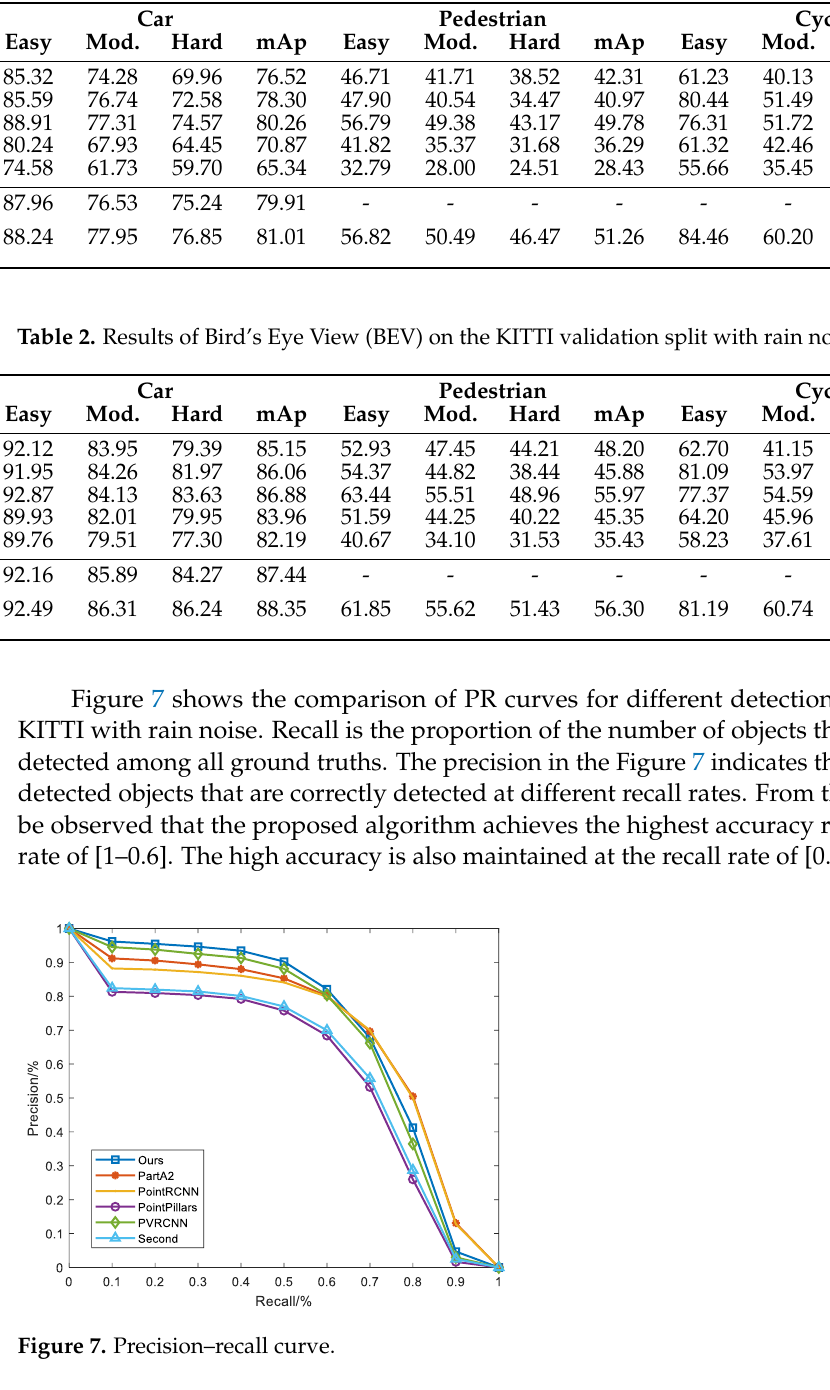
Table 1. Results of 3D detection on the KITTI validation split with rain noise after training.